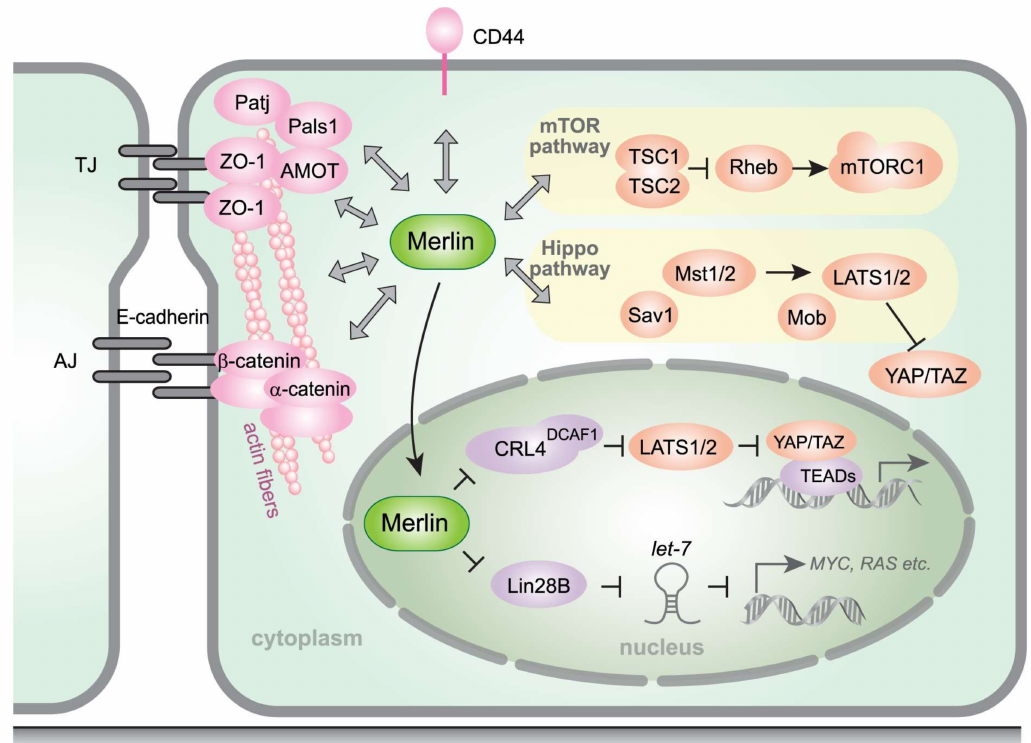
Figure 2. A model of the NF2 /merlin signaling pathway. Merlin is involved in contact inhibition by interacting with many membrane-associated proteins such as CD44 [26,27], the angiomotin (AMOT) –Patj–Pals1 complex [48], E-cadherin– α -catenin [30,55], and actin fibers. A loss of merlin expression disrupts cancer-related signaling through the Hippo and mTOR pathways. Merlin is also localized in the nucleus where it binds to and inhibits E3 ubiquitin ligase CRL4 DCAF1 , which promotes LATS1/2 degradation [66,67], and RNA-binding protein Lin28B, which suppresses let-7 miRNAs that are involved in the silencing of oncogenes such as MYC and RAS [68]. TJ: tight junction; AJ: adherens junction; ZO-1: Zonula occludens-1; AMOT: angiomotin; mTOR: mechanistic target of